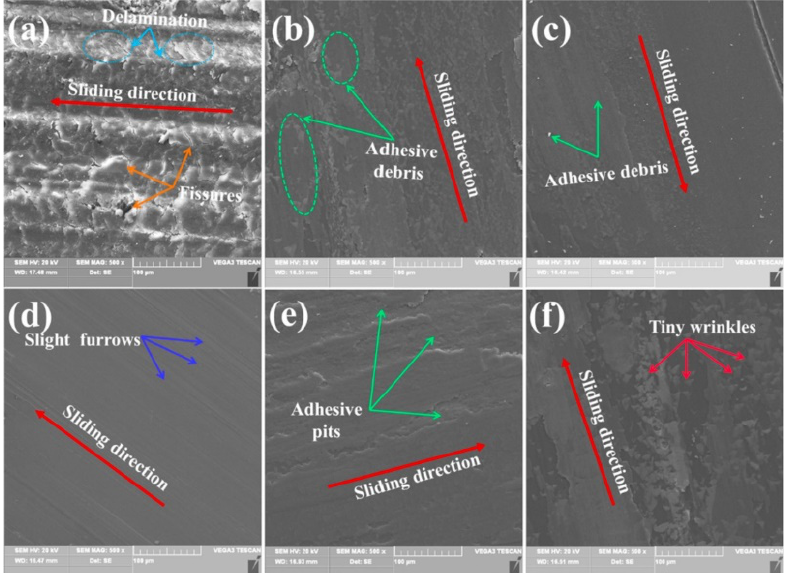
Fig. 7 Scanning electron microscopy images of worn surfaces of (a) bismaleimide resin and its composites incorporating: (b) 0.2 wt%, (c) 0.4 wt%, (d) 0.6 wt%, (e) 0.8 wt%, and (f) 1.0 wt% PHbP@rGO/WS 2 . Reproduced with permission from Ref. [155], © Elsevier Ltd. 2019.